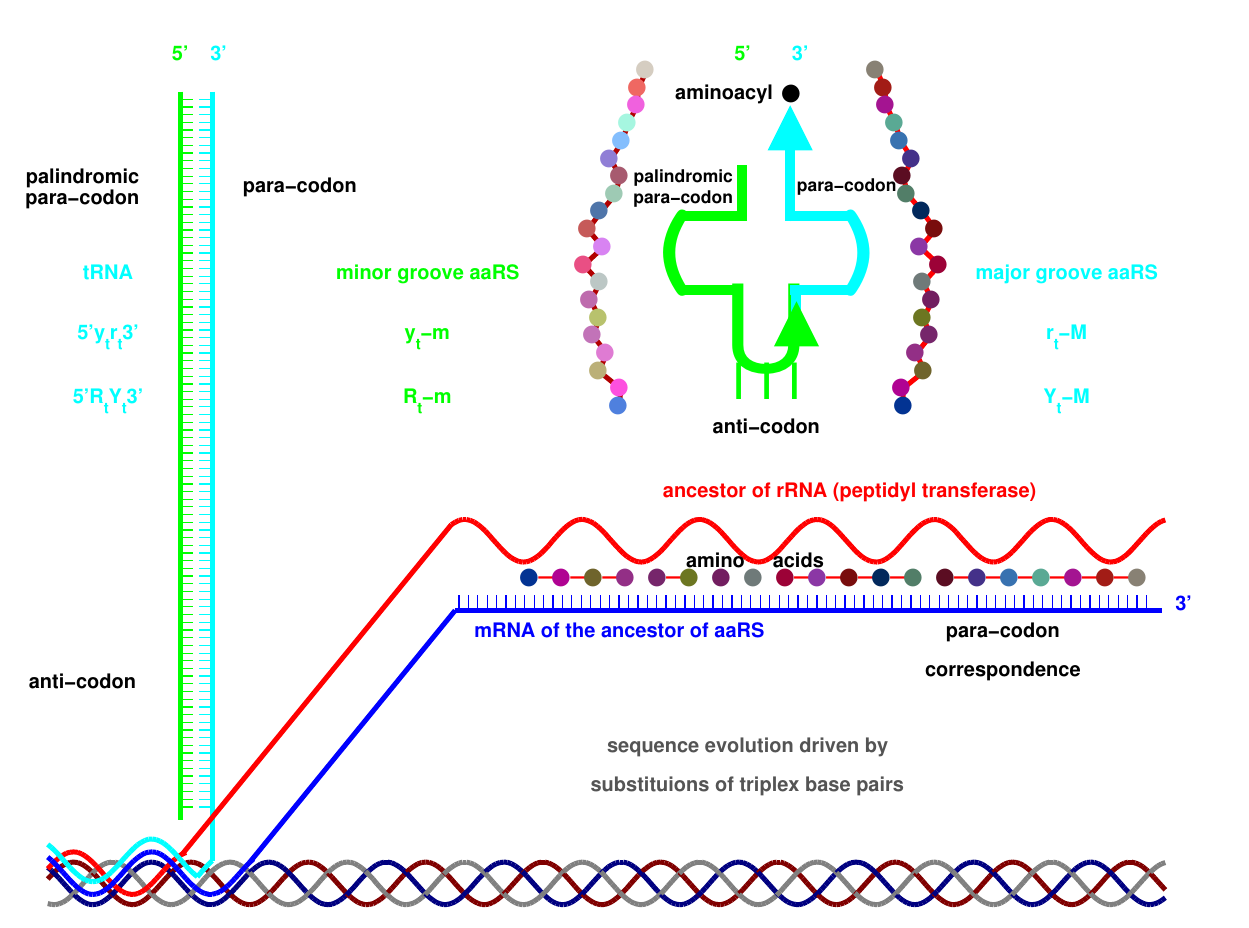
Figure 8. The origin and evolution of four classes of early aaRSs in the junior stage of the primordial translation mechanism in absent of tRNA and ribosome. The first aaRS can be produced through the non-random evolution of the triplex DNA and the corresponding RNAs. At the beginning of the translation mechanism, DNAs are the carrier of information, and RNAs develop the functions of